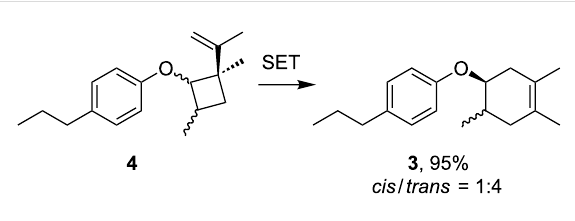
Scheme 5: Oxidative SET-triggered rearrangement of vinyl cyclo- butane 4 . Conditions: 1.0 M LiClO 4 /CH 3 NO 2 , carbon felt